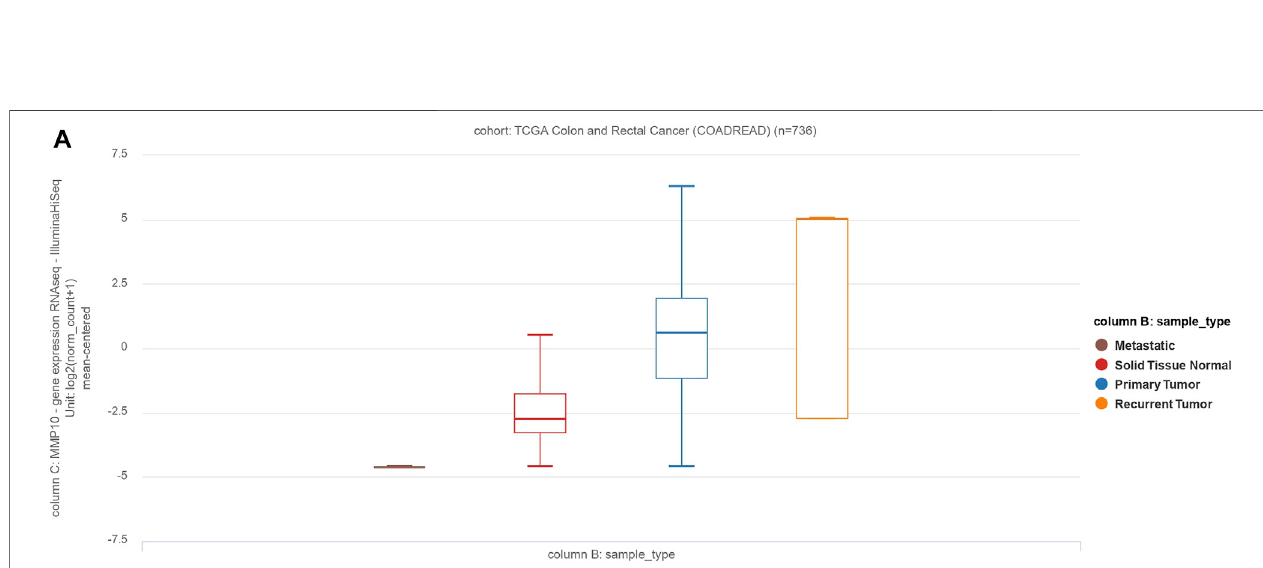
FIGURE 6 | The MMP10, LCN2, REG1A, REG3A, and DUOX2 expression pro fi les and clinicopathological data of colon adenocarcinoma cases and rectum adenocarcinoma (READ). Data are from The Cancer Genome Atlas (TCGA). (A) : MMP10, (B) : LCN2, (C) : REG1A, (D) : REG3A, (E) : DUOX2 .